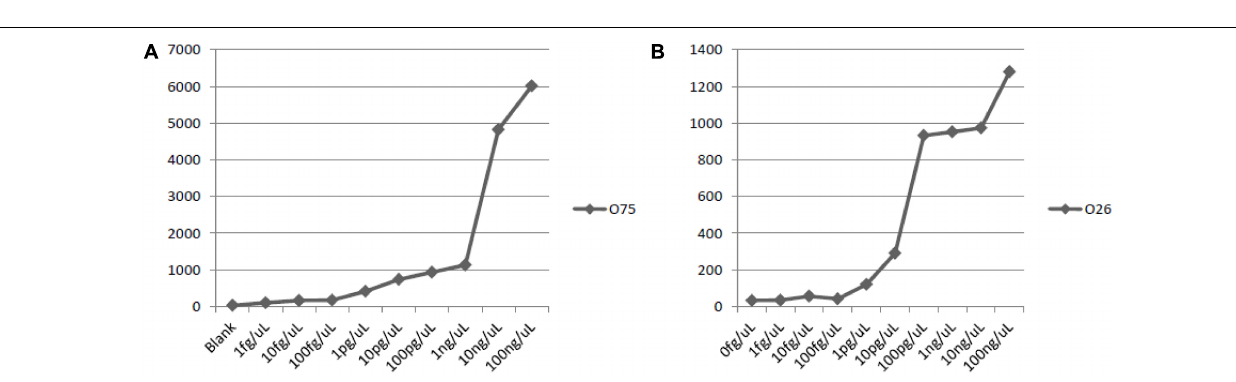
FIGURE 4 | Specific detection by the xMAP bead-based multiplex assay on the 12 P. shigelloides O-antigens. MFI, median fluorescent intensity; the X -axis represents P. shigelloides strains of the 12 O-antigens. (A) Group A; (B) Group B.